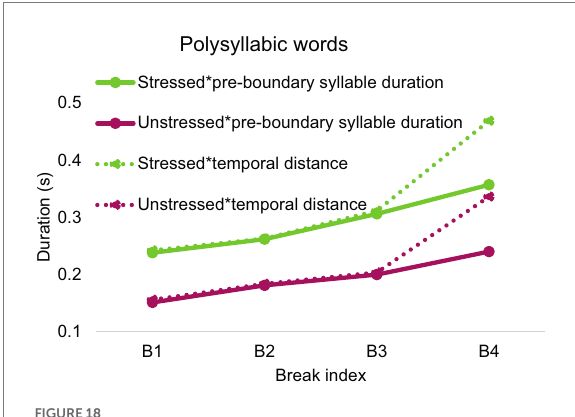
FIGURE 18 Pre-boundary syllable duration and temporal distance over break index after polysyllabic words in English.